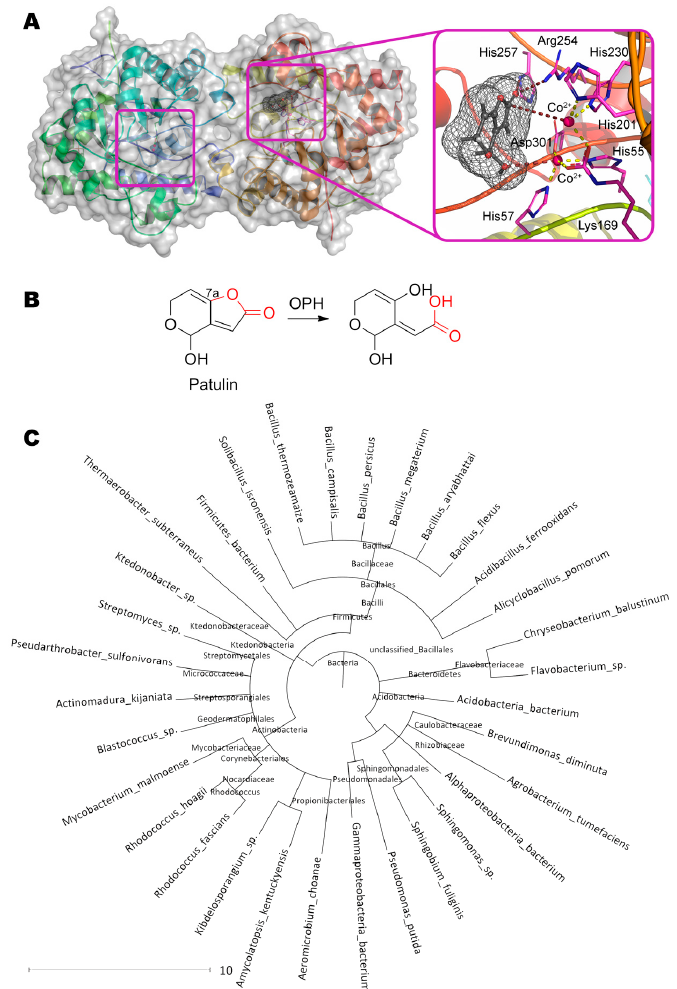
Figure 8. ( A ) Structure of organophosphorus hydrolase (PDB 1qw7) containing patulin in its active center, and ( B ) scheme of substrate conversion with organophosphorus hydrolase. Position and geometry of substrate binding was determined as described early. ( C ) Phylogenetic tree of microorganisms possessing homologous enzymes found with BLAST.